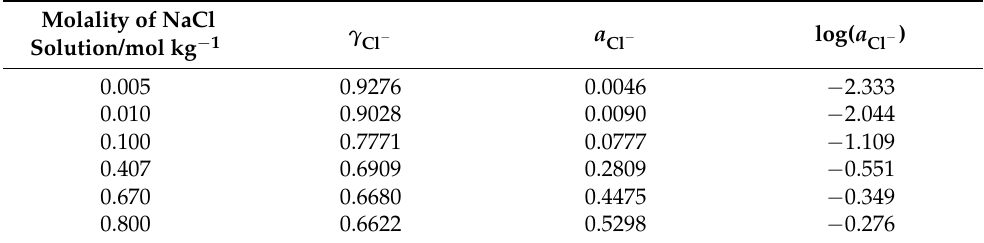
Table 3. Activity coefficients of chloride ions for each tested NaCl solution based on which were calculated the activities of chloride